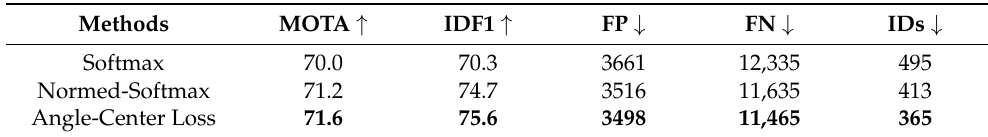
Table 3. Comparison of two loss functions and proposed angle-center loss (ACL) for the re-ID branch in CSMOT. The best results are shown in bold